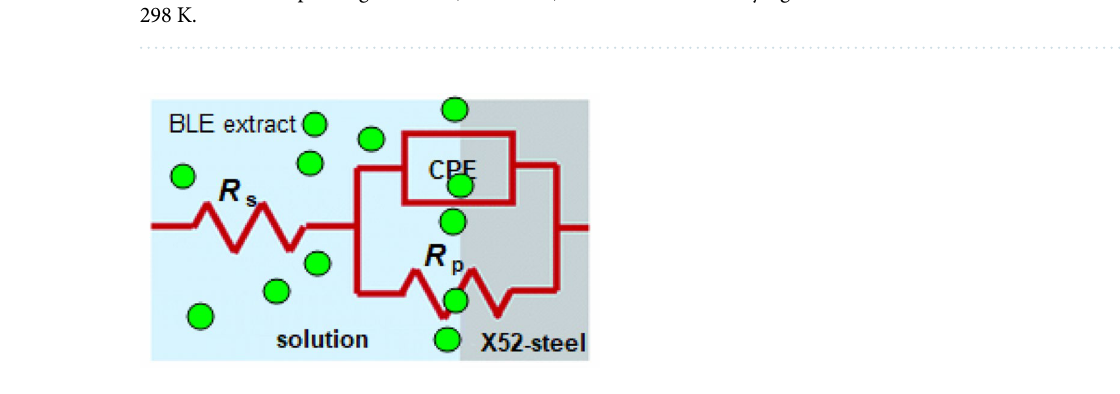
Figure 7. The equivalent circuit for fitting of the impedance data.